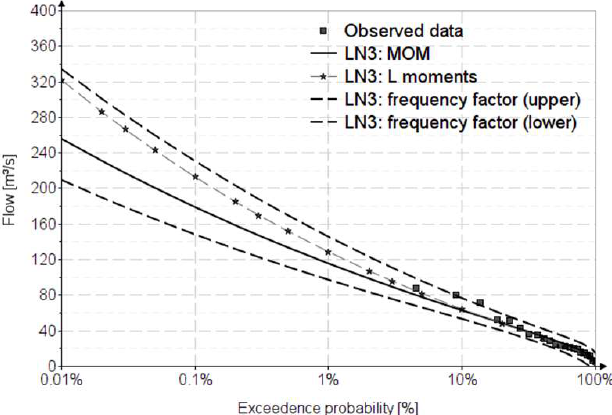
Figure 11. LogNormal distribution.